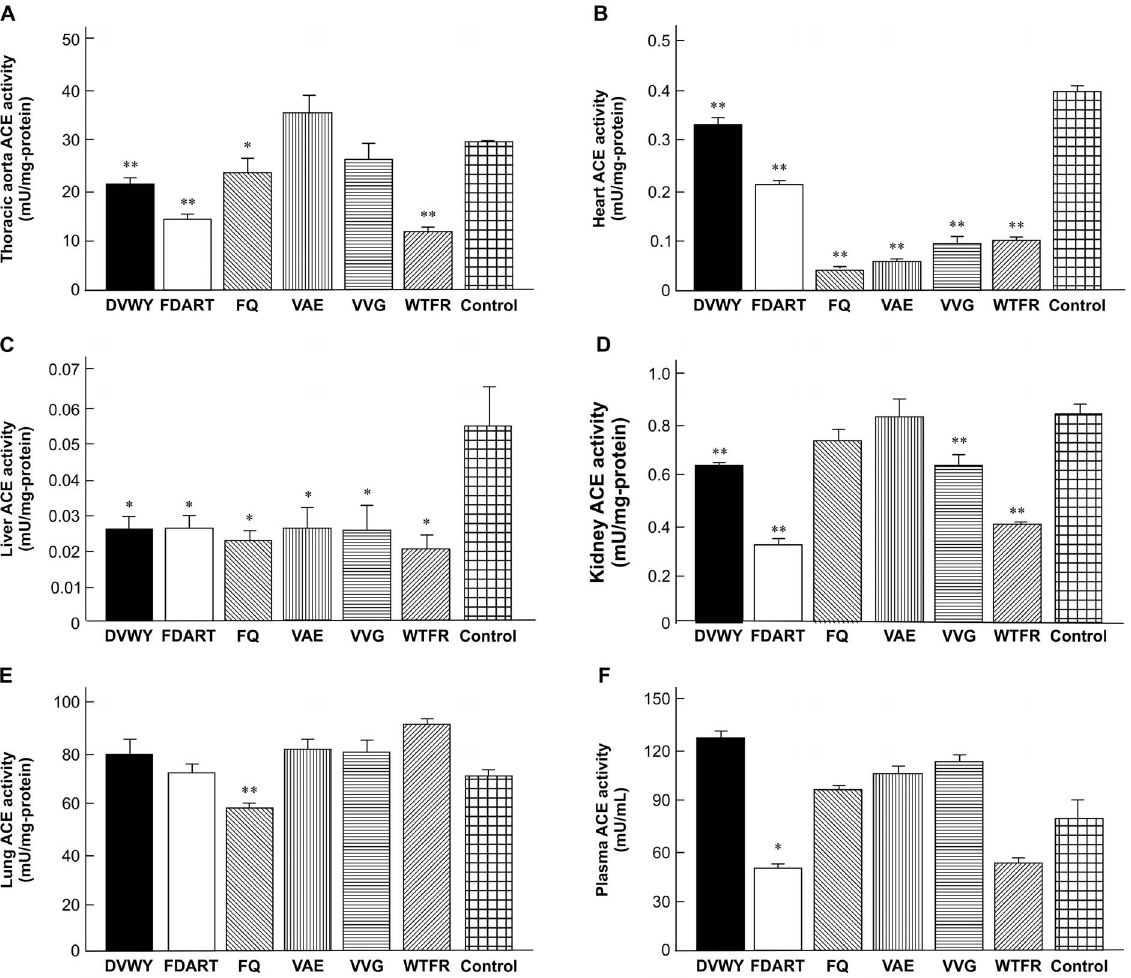
Figure 2. Tissue and plasma ACE activities in SHRs after treatment with FBPs. Animals were treated with FBPs at a dose of 10 mg/kg BW. The levels of ACE activity in thoracic aorta (A), heart (B), liver (C), kidney (D), lung (E), and plasma (F) were determined 6 hours after administration. Data represent the mean 6 S.E. (n=6). * p , 0.05, ** p , 0.01 versus the control group (purified water administration), Student’s t -test. doi:10.1371/journal.pone.0105802.g002 PLOS ONE |